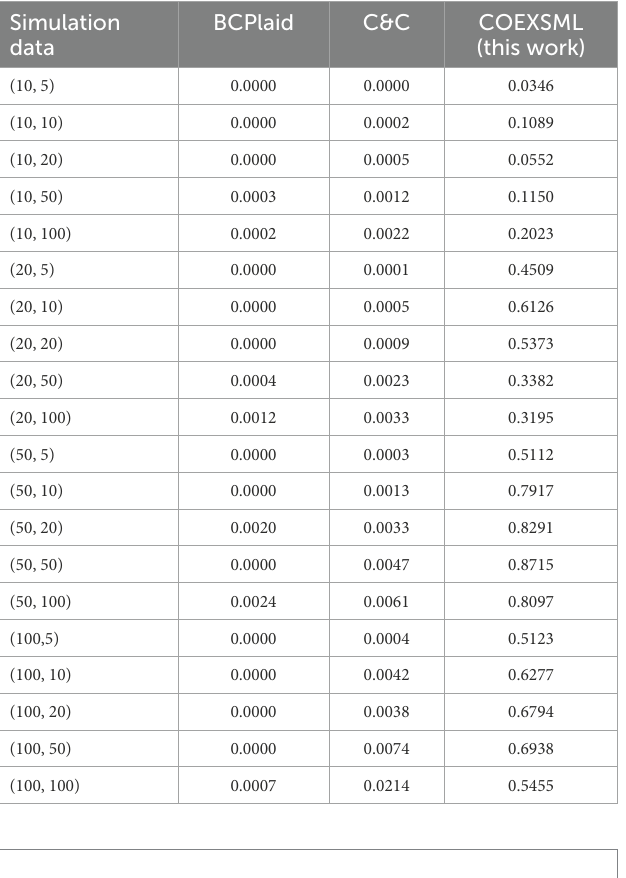
TABLE 3 The jaccard similarity coefficient between the clustering results identified by the three methods on different simulated datasets and the real clusters, where simulation data represents (the number of samples, the number of genes).